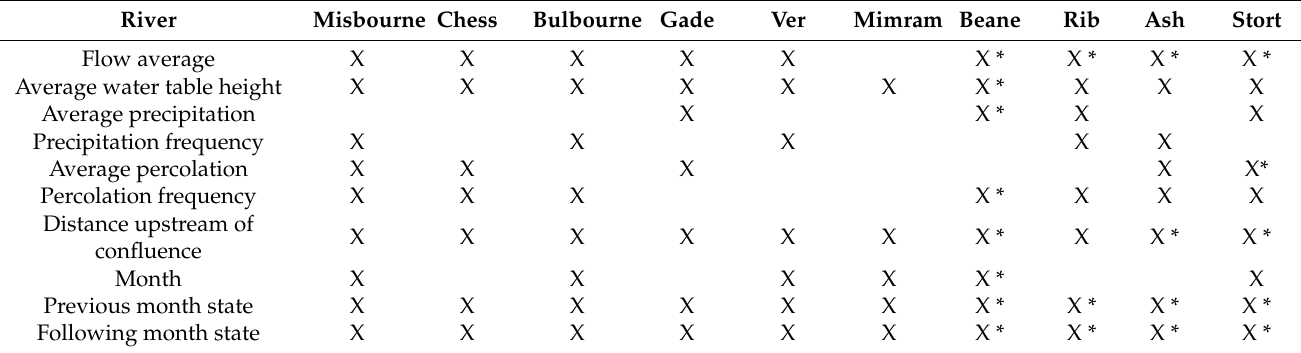
Figure 3. Relationships between Base Flow Index and weighted evaluation metrics. ( a ) POD; ( b ) POFD; ( c ) f; ( d ) CCR. Table 4. Coefficients that were identified (x) as significant predictors of hydrological state in their respective models. * denotes non-proportional odds